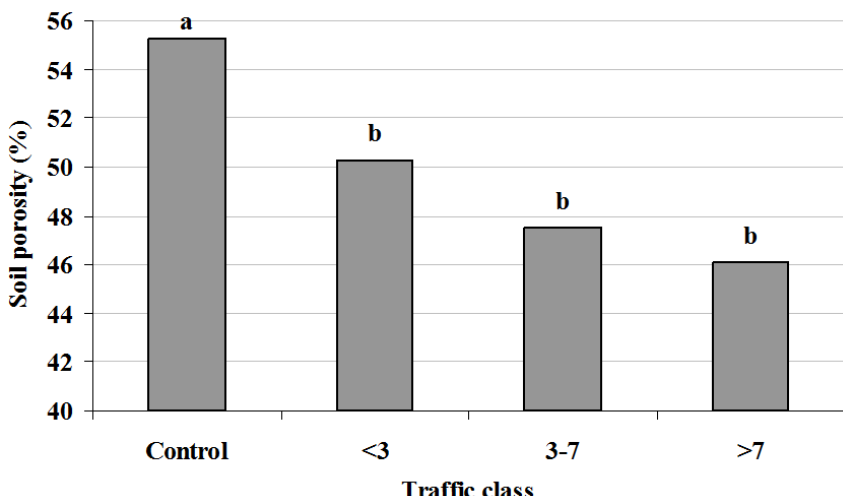
Fig. 5. Average of the soil porosity in g cm –3 and its relative changes before and after skidding in each of the traffic classes using Duncan’s test (b). Different letters within each slope treat- ments shows significant differences ( p <